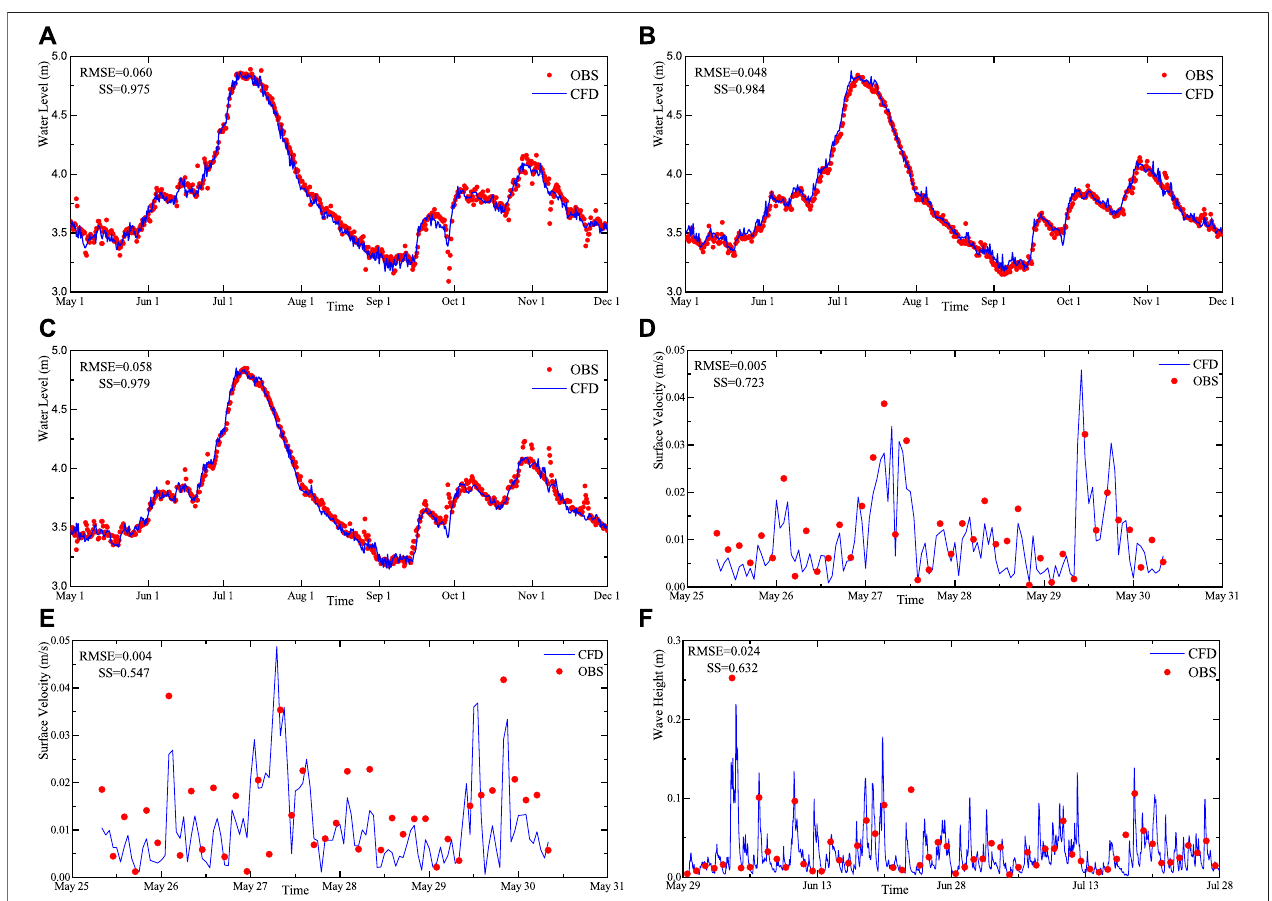
FIGURE 6 | Comparison between numerical simulation results and observed data. (A) WL1, (B) WL2, (C) WL3, (D) VM1, (E) VM2, and (F) WH1.